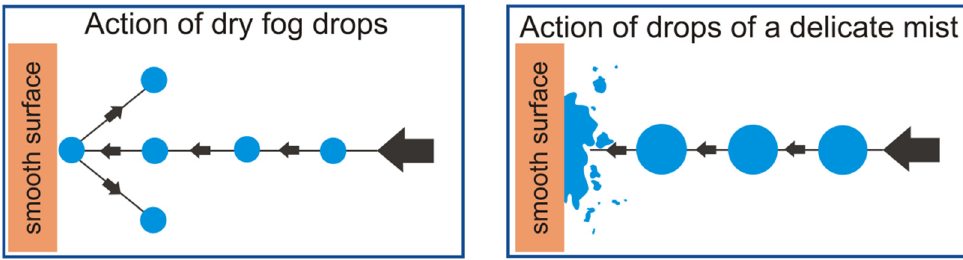
Figure 1. Dry fog effect.